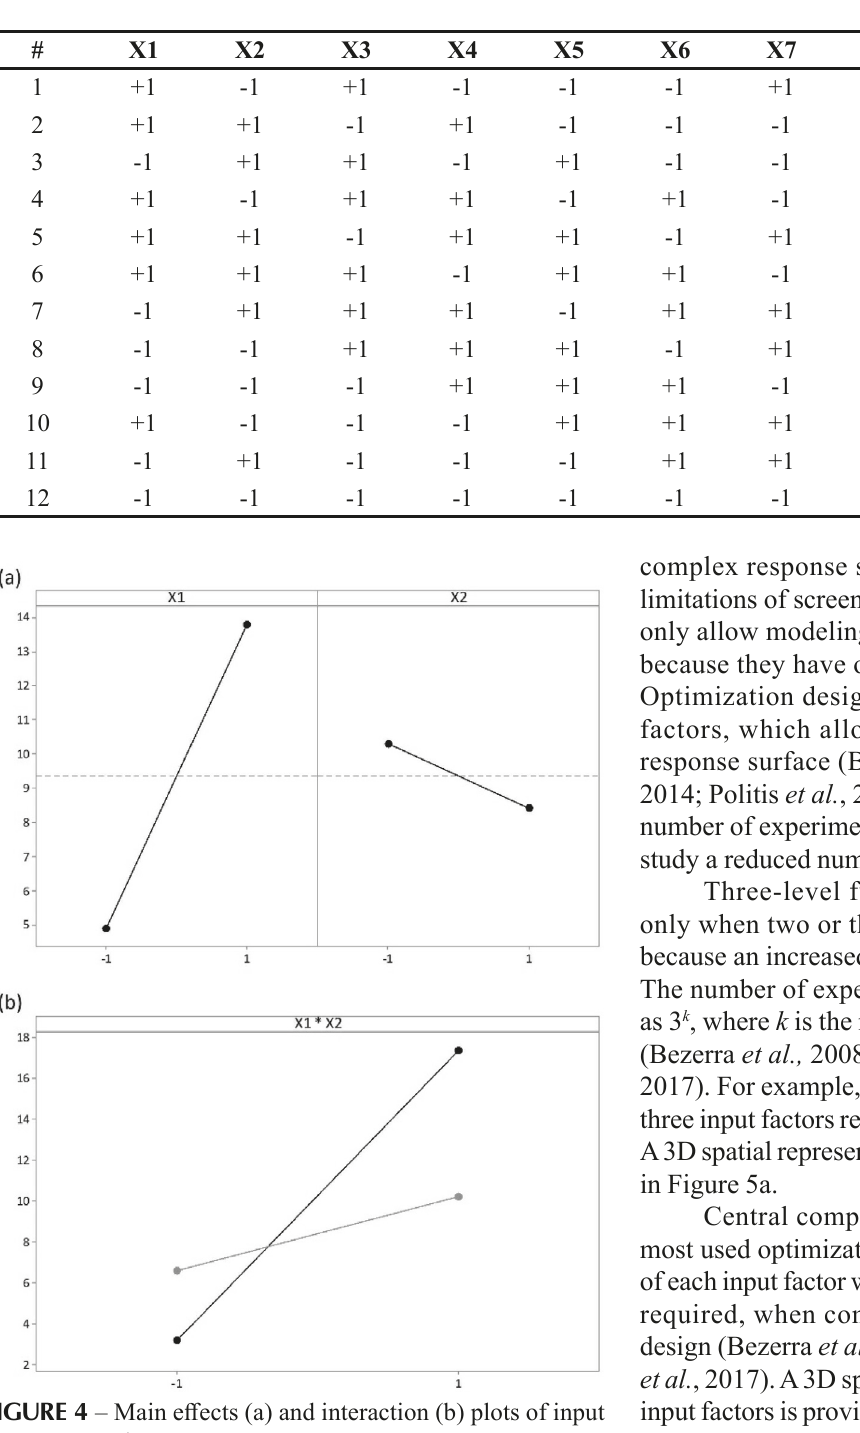
TABLE IV – Plackett-Burman design matrix to study 11 input factors (X1 to X11) with 12 experiments